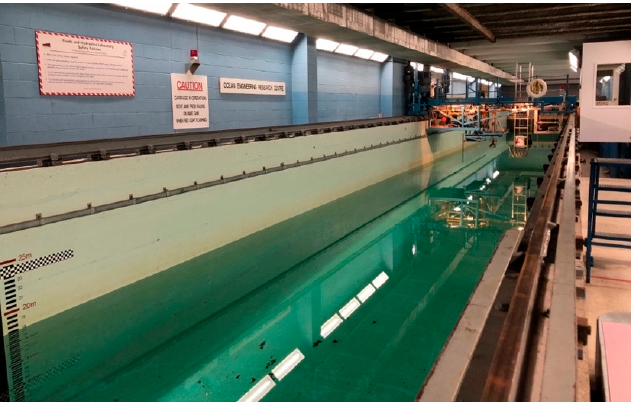
Figure 4. OERC tow tank of Memorial University of Newfoundland.